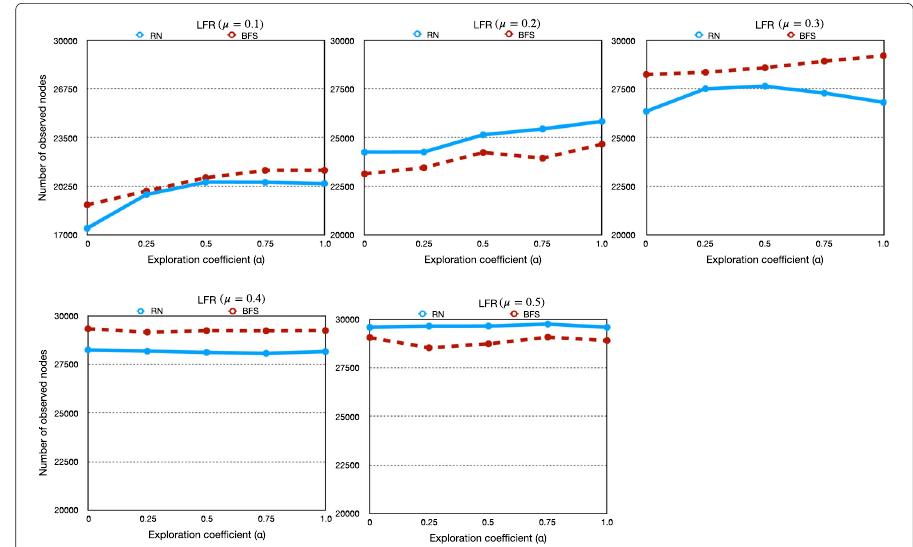
10 independently sampled partially observed